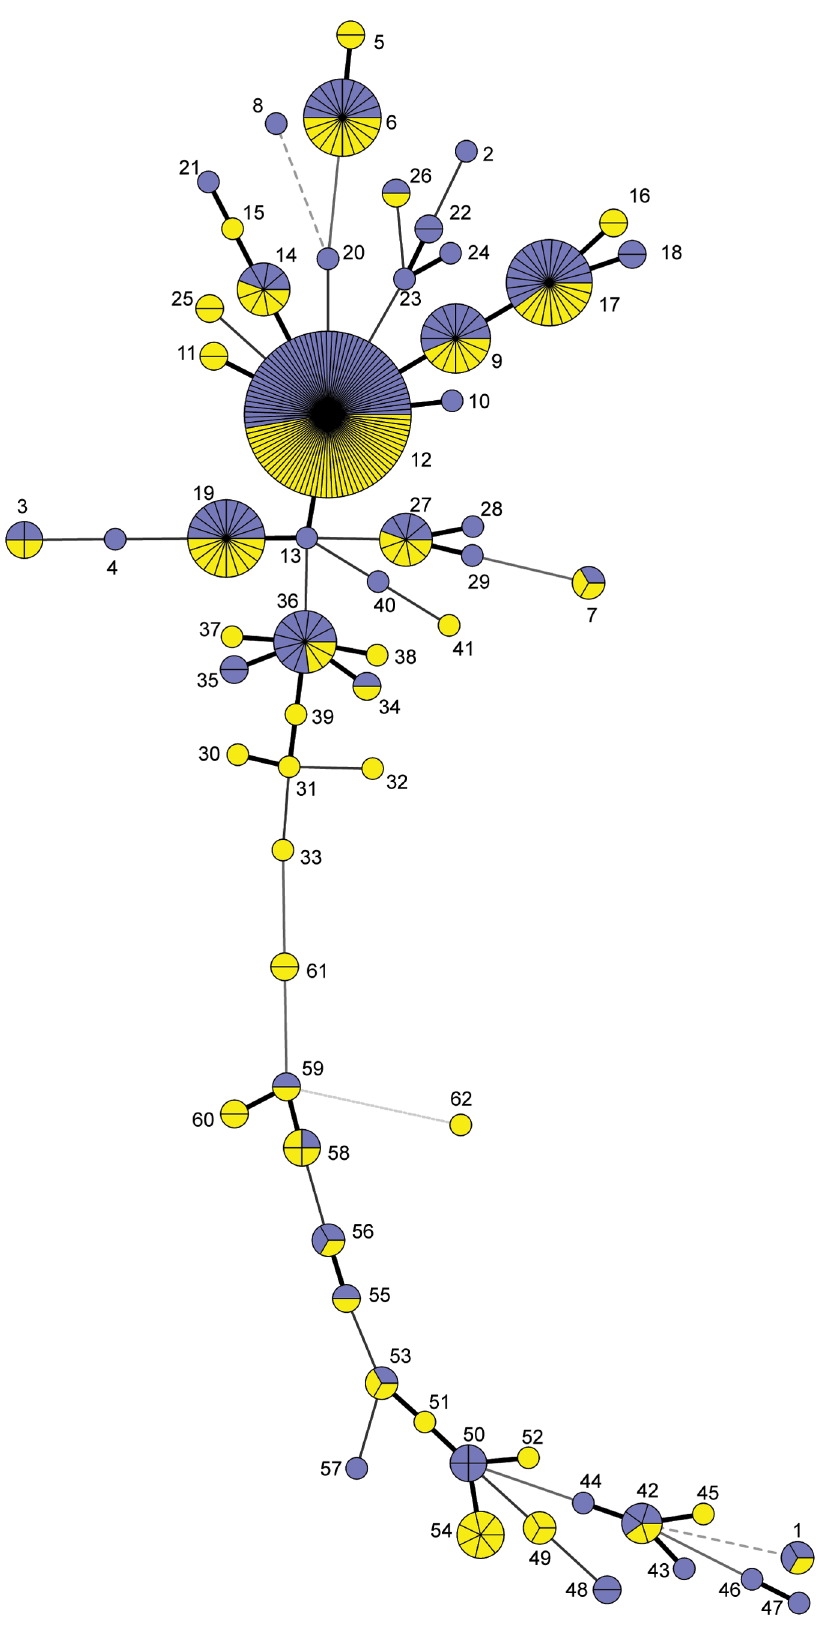
Figure 2. Minimum spanning tree with categorical data of all 62 MLVA types containing all 304 isolates. Each circle is labeled with the MLVA type it represents. The size of the circle and number of divisions represent the number of isolates of that type. The blue and yellow segments